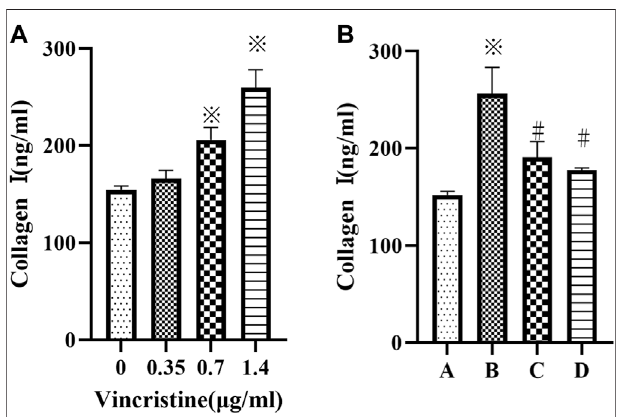
FIGURE 2 | (A) : Cells were treated with different concentration of vincristine(0,0.35, 0.7and1.4 μ g/ml)for24 h* p < 0.05 vs .thecontrolgroup. (B) : VCR-induced collagen I production was decreased by SB203580 and PD98059(cellsweretreatedwith1.4 μ g/mlVCRfor24 h).Wemeasured the level of collagen I using ELISA assay. * p < 0.05 vs . the control group; # p < 0.05 vs . theVCR group. A:control group, BVCR group, C:SB203580 group, D: PD98059 group.